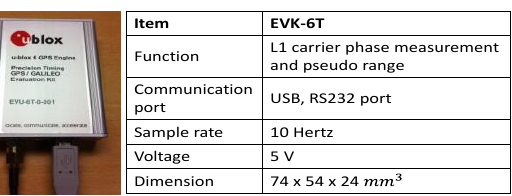
Figure 4 GNSS receiver of DG module